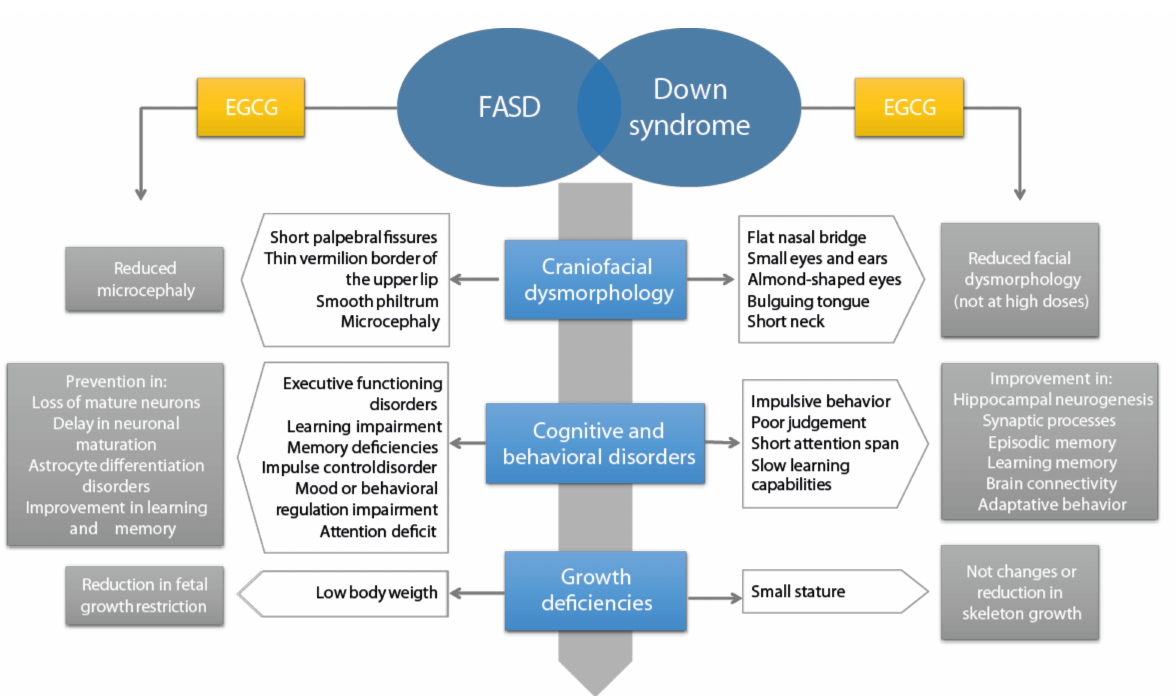
Figure 3. Common pathophysiological characteristics of Fetal Alcohol Spectrum Disorders (FASD) and Down syndrome, and effect of epigallocatechin-3-gallate (EGCG) on the different